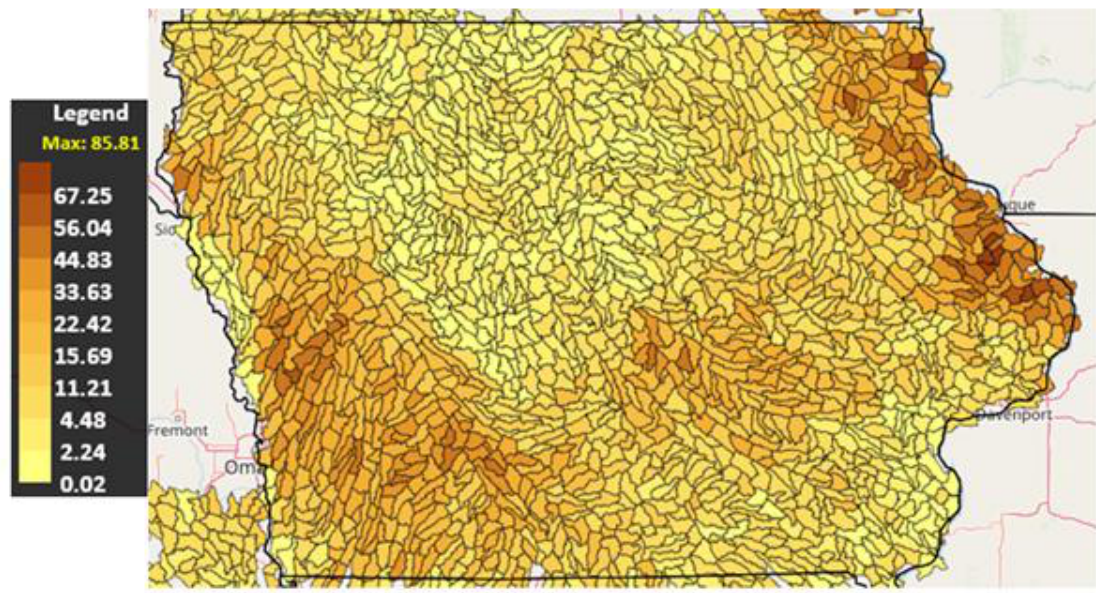
Figure 3. As an example, estimated annual soil loss for the 2017–2018 water year across Iowa, illustrating erosion rates from 3 to more than 70 Mg/ha. The latter corresponds to an erosion rate of roughly 6 mm (0.2 inch) of soil loss in four years. Figure courtesy of the Daily Erosion Project (www.dailyerosion.org).